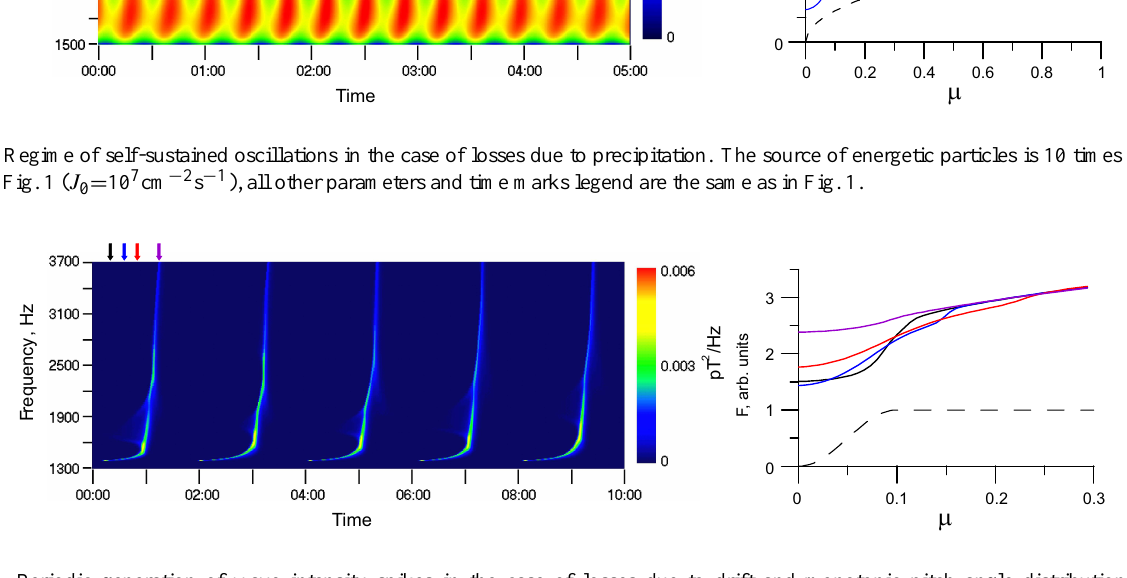
Fig. 4. Periodic generation of wave intensity spikes in the case of losses due to drift and monotonic pitch angle distribution in the source Eq. (18). System parameters are L =4.4, n cL = 55 cm − 3 , W 0 = 45 keV, ln R = 2 ω/ω 0 , the density of drifting energetic particles n hL = 0 . 04 cm − 3 , the duct radius in the equatorial plane 100 km; source parameters are æ = 0 . 1, δ = 2. The same time marks legend as in Fig. 1 is used. The pitch angle distribution in the source is shown by the dashed